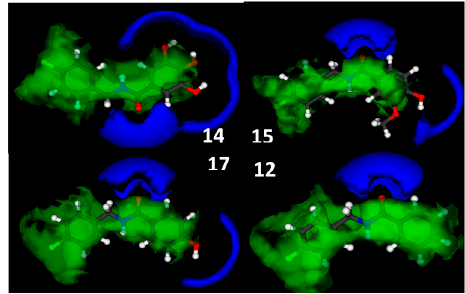
Figure 2. Gallic amide ( 14 ), vanillic amide ( 15 ), 4-hydroxybenzoic amide ( 17 ) and benzoic amide ( 12 ) interaction fields: energy level − 0.6 kcal/mol DRY, and − 3 kcal/mol N1 in VolSurf.